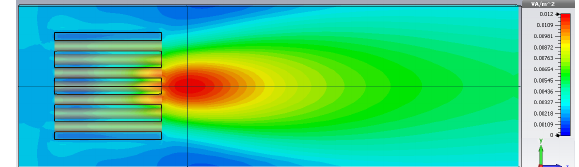
Fig.4. Simulation of metamaterial aided birefringent photonic jet for spectroscopic